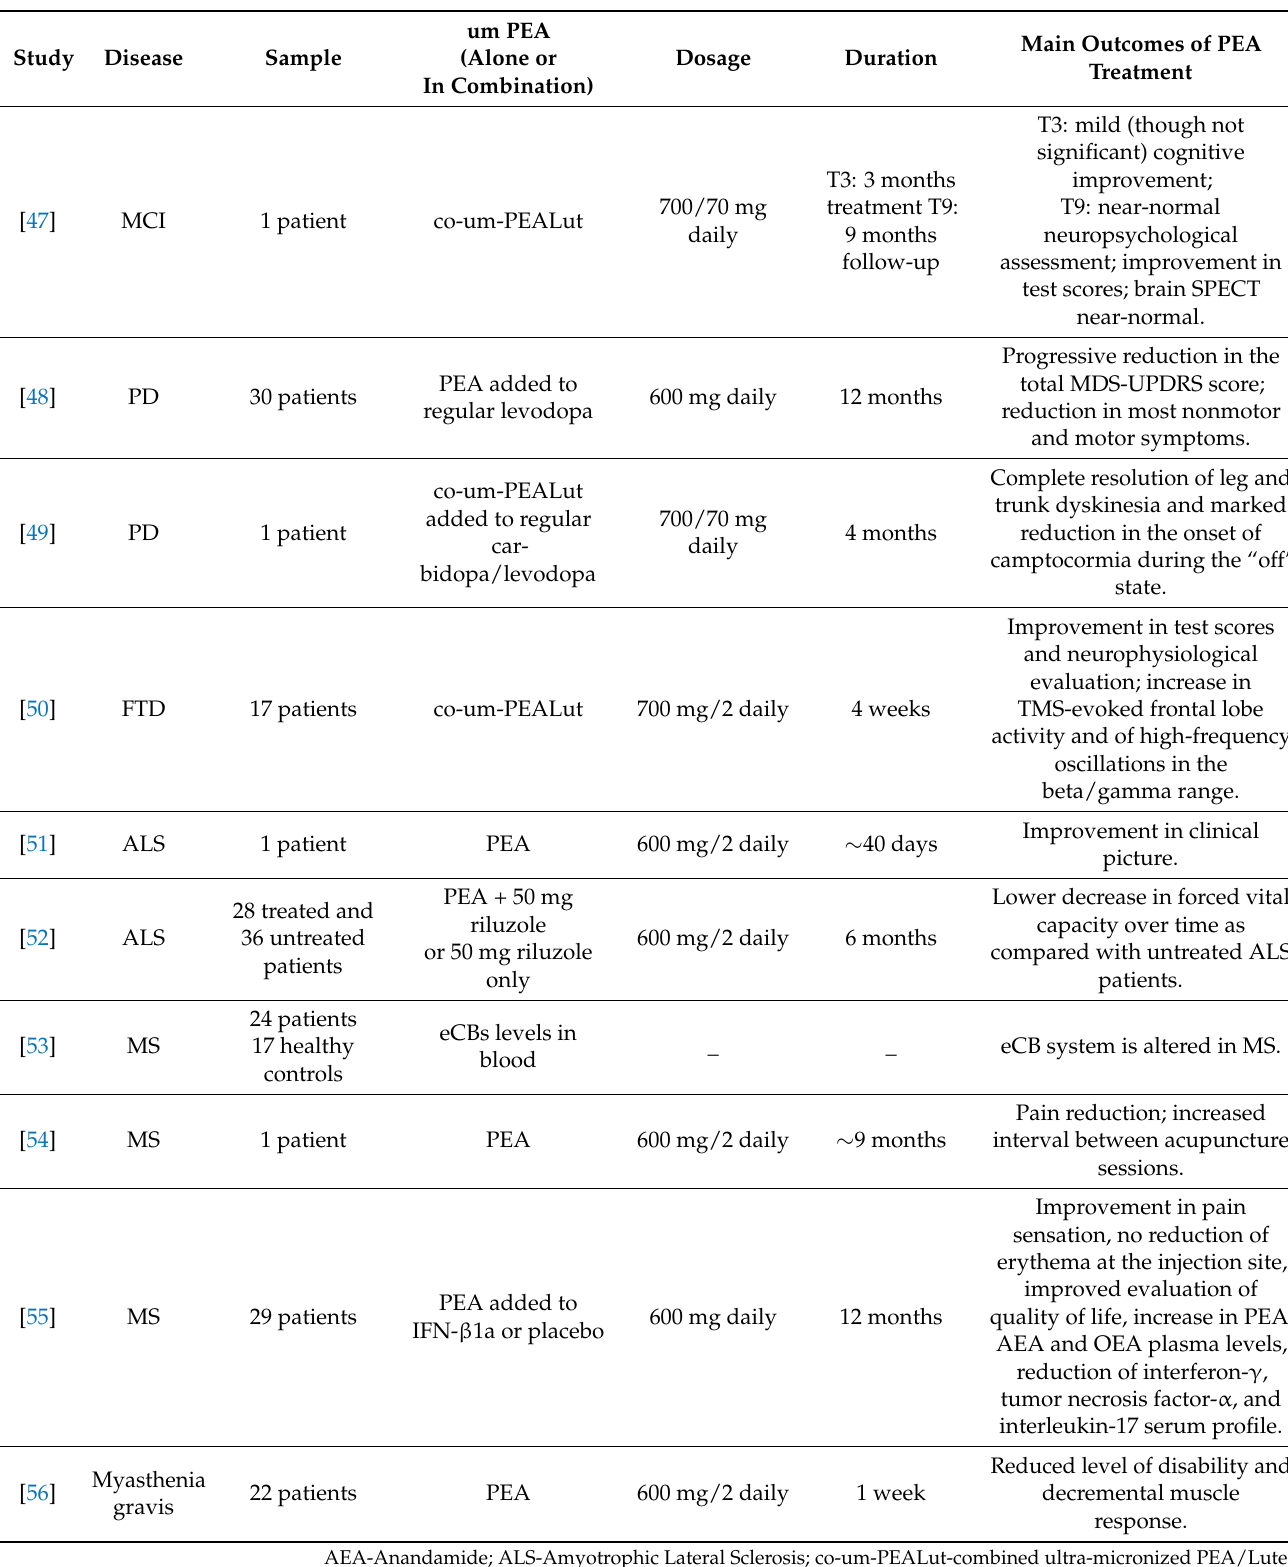
Table 1. Summary of human studies using PEA in the presence of